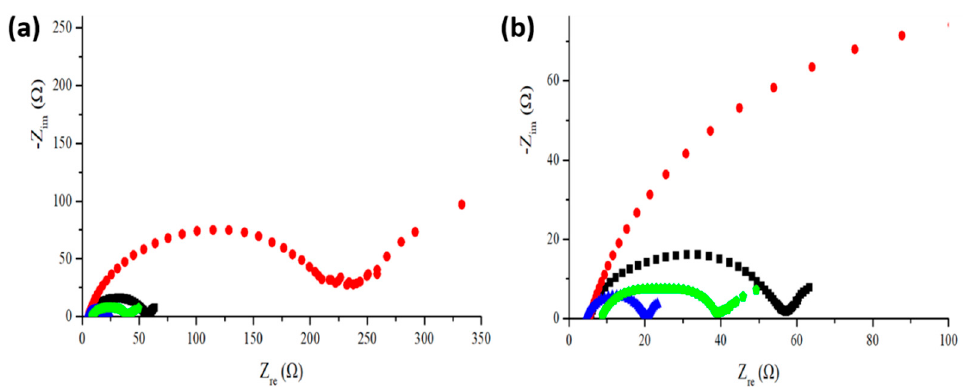
Figure 10. ( a ) Electrochemical impedance spectra measured from as-fabricated anode and after 150 cycles of discharge/charge at 0.2 C for anode made of (black square) pristine silicon flakes, (red dots) pristine silicon flakes after cycling, (blue triangle) silicon flakes with a combined SiC and RF carbon coatings, and (green pentagon) silicon flakes with a combined SiC and RF carbon coatings after cycling. ( b ) Enlarged spectra shown in ( a ).